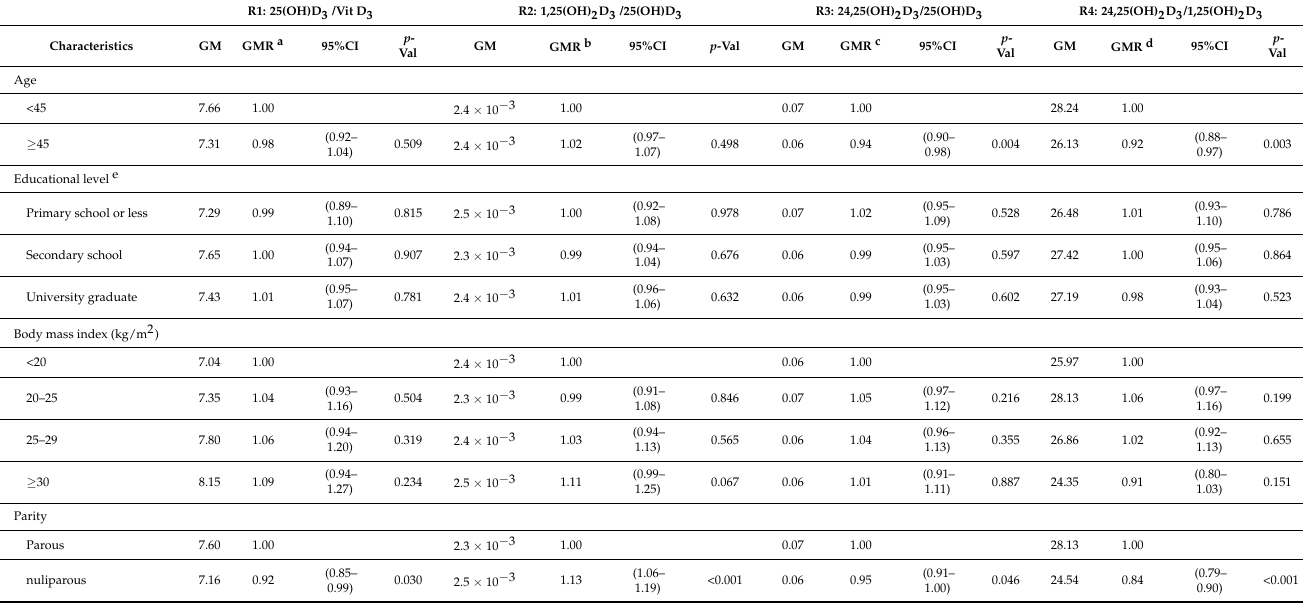
Table 3. Association between vitamin D metabolite ratios and characteristics of